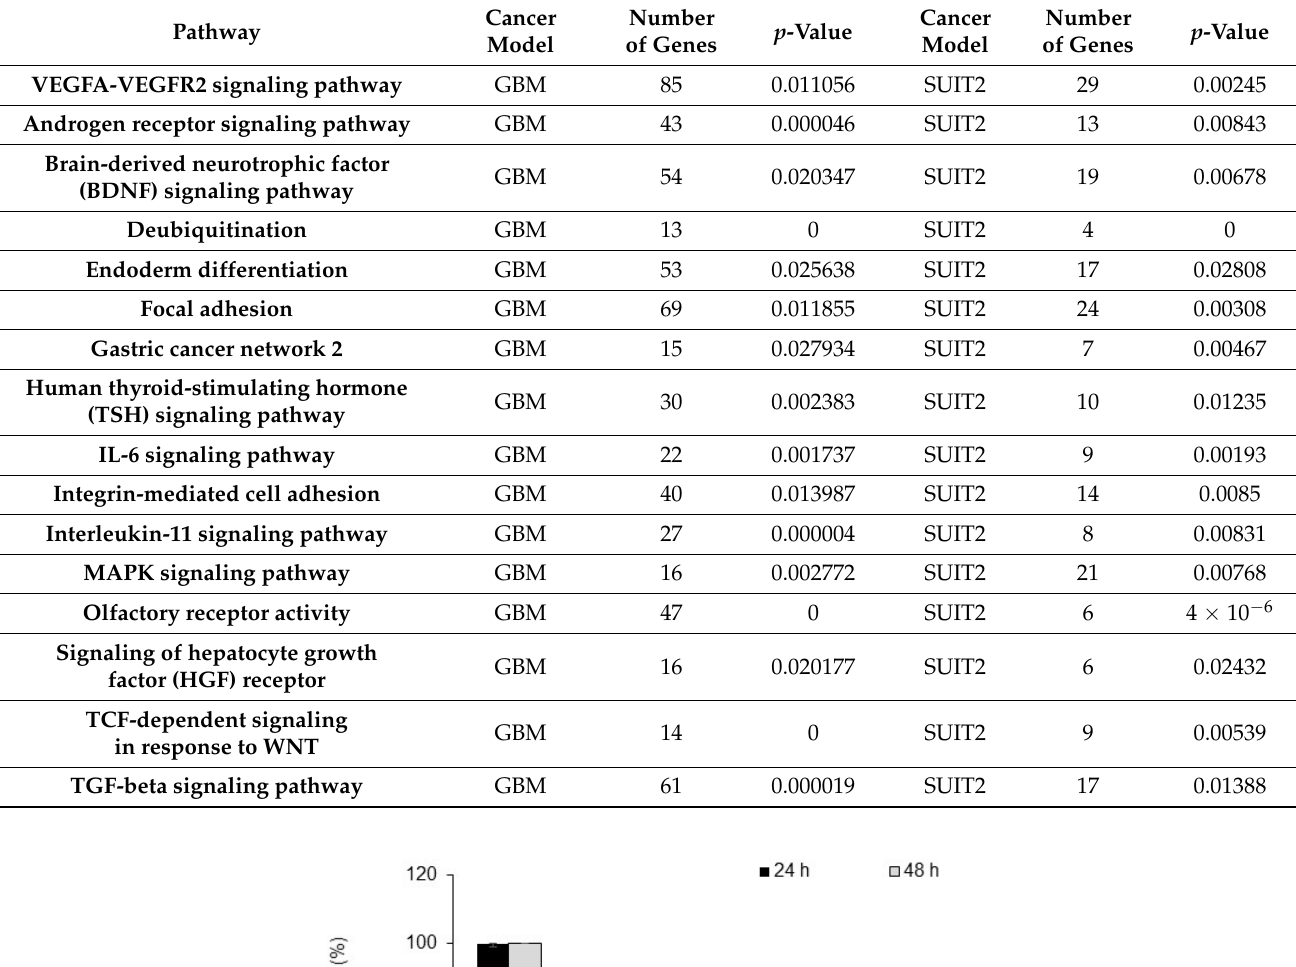
Table 3. Effects of P-bi-TAT treatment on gene expression of sixteen common pathways significantly affected in both human glioblastoma multiforme (GBM) and metastatic pancreatic carcinoma (SUIT2) cells. Genes’ expression that was significantly affected by P-bi-TAT treatment was independently iden- tified in GBM and SUIT2 cells and subjected to gene set enrichment analyses to identify significantly enriched pathways. Affected genes are listed in Supplemental Table S1.